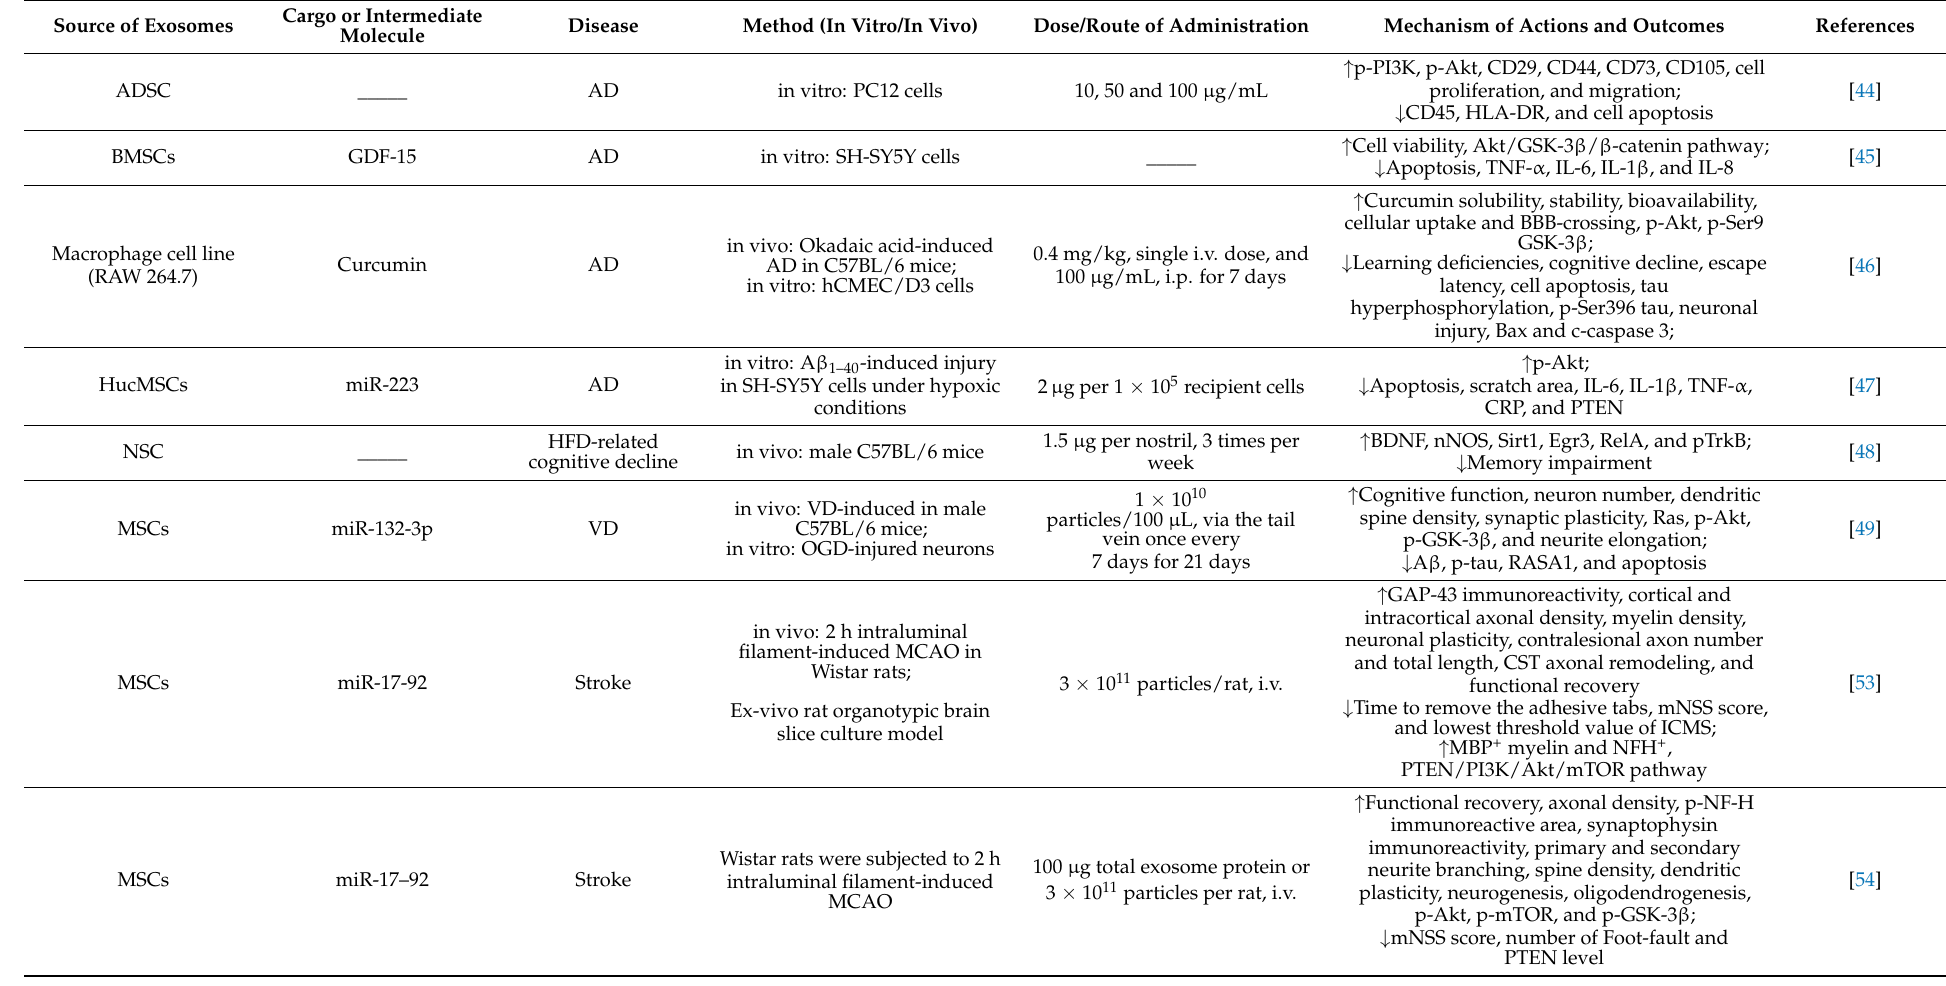
Table 1. Exosomes circumvent AD and stroke via PI3K/Akt/mTOR and associated